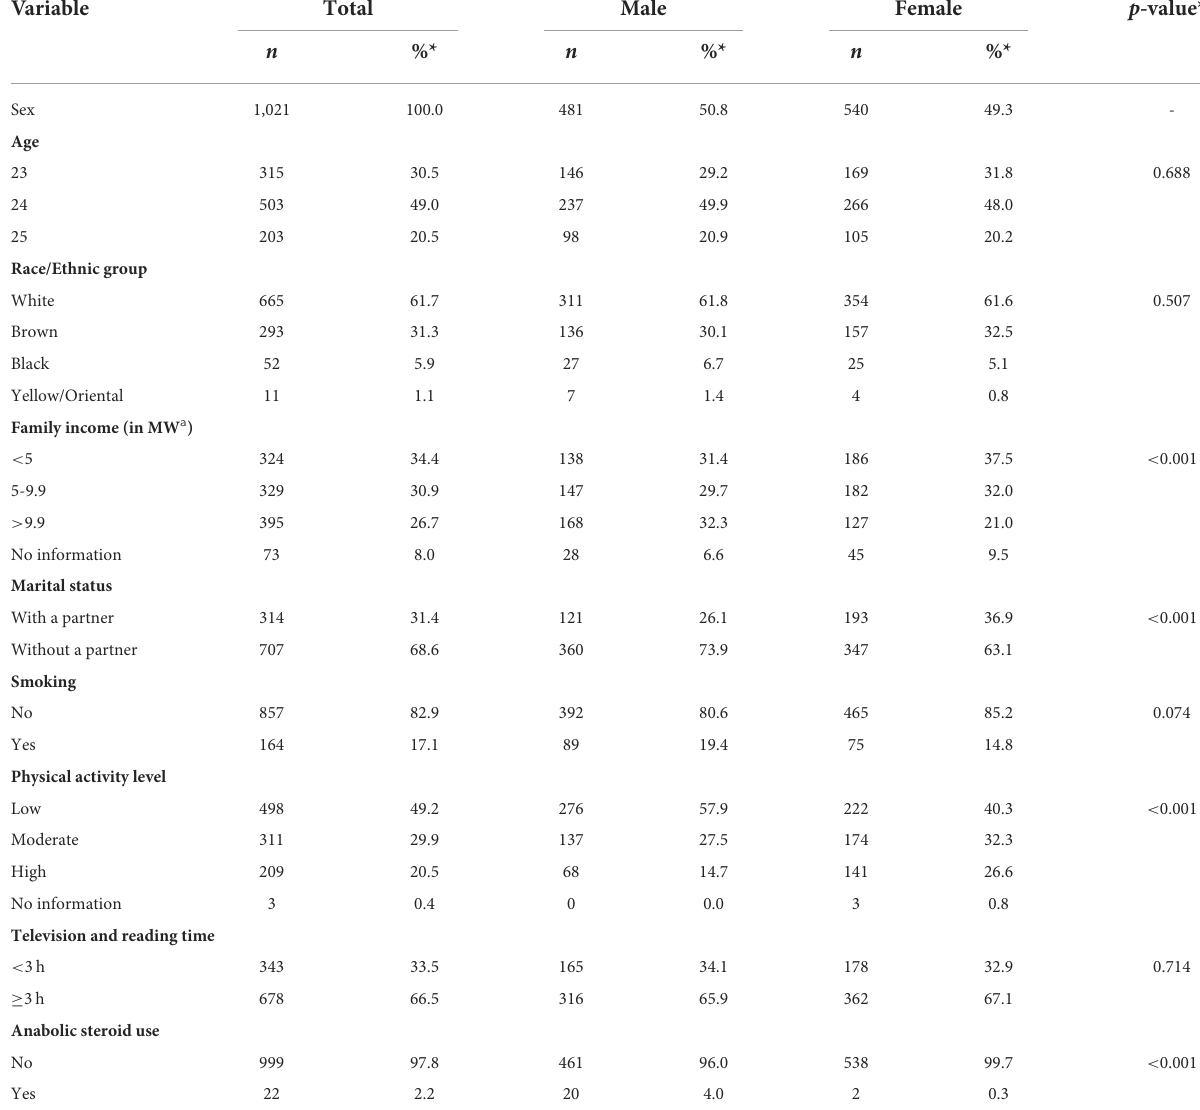
TABLE 1 Sociodemographic characteristics and lifestyle habits of adults aged 23–25 years participating in the 1978/1979 Ribeirão Preto birth cohort study (São Paulo, Brazil, 2002–2004). Variable Total